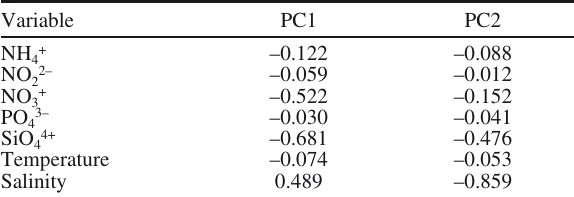
Table 2. – First two principal components generated by the principal component analysis of physicochemical parameters Variable